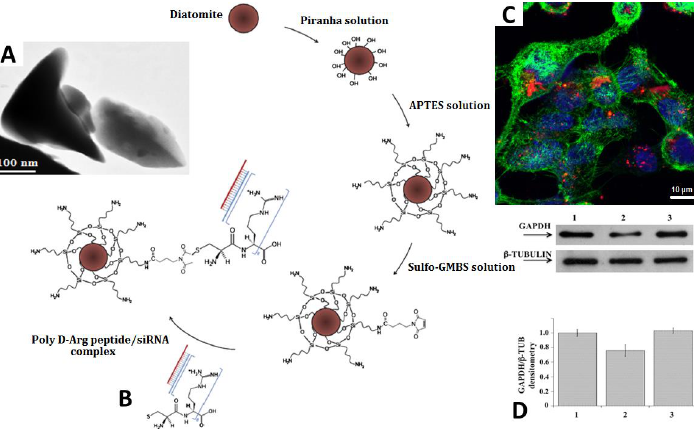
Figure 4. ( A ) Schematic representation of DNP functionalization with PEG and CPP-peptide. ( B ) SEM pictures of the red blood cell morphological modification after the exposure to the modified DNPs. ( C ) Transmission electron microscope (TEM, upper panel) and confocal (lower panel) imaging of MCF-7 cells treated with 50 µg/ml of DNPs-APT, DNPs-APT-PEG, and DNPs-APT-PEG-CPP for 12 h at 37 °C. Adapted with permission from [57], Royal Society of Chemistry, 2015.